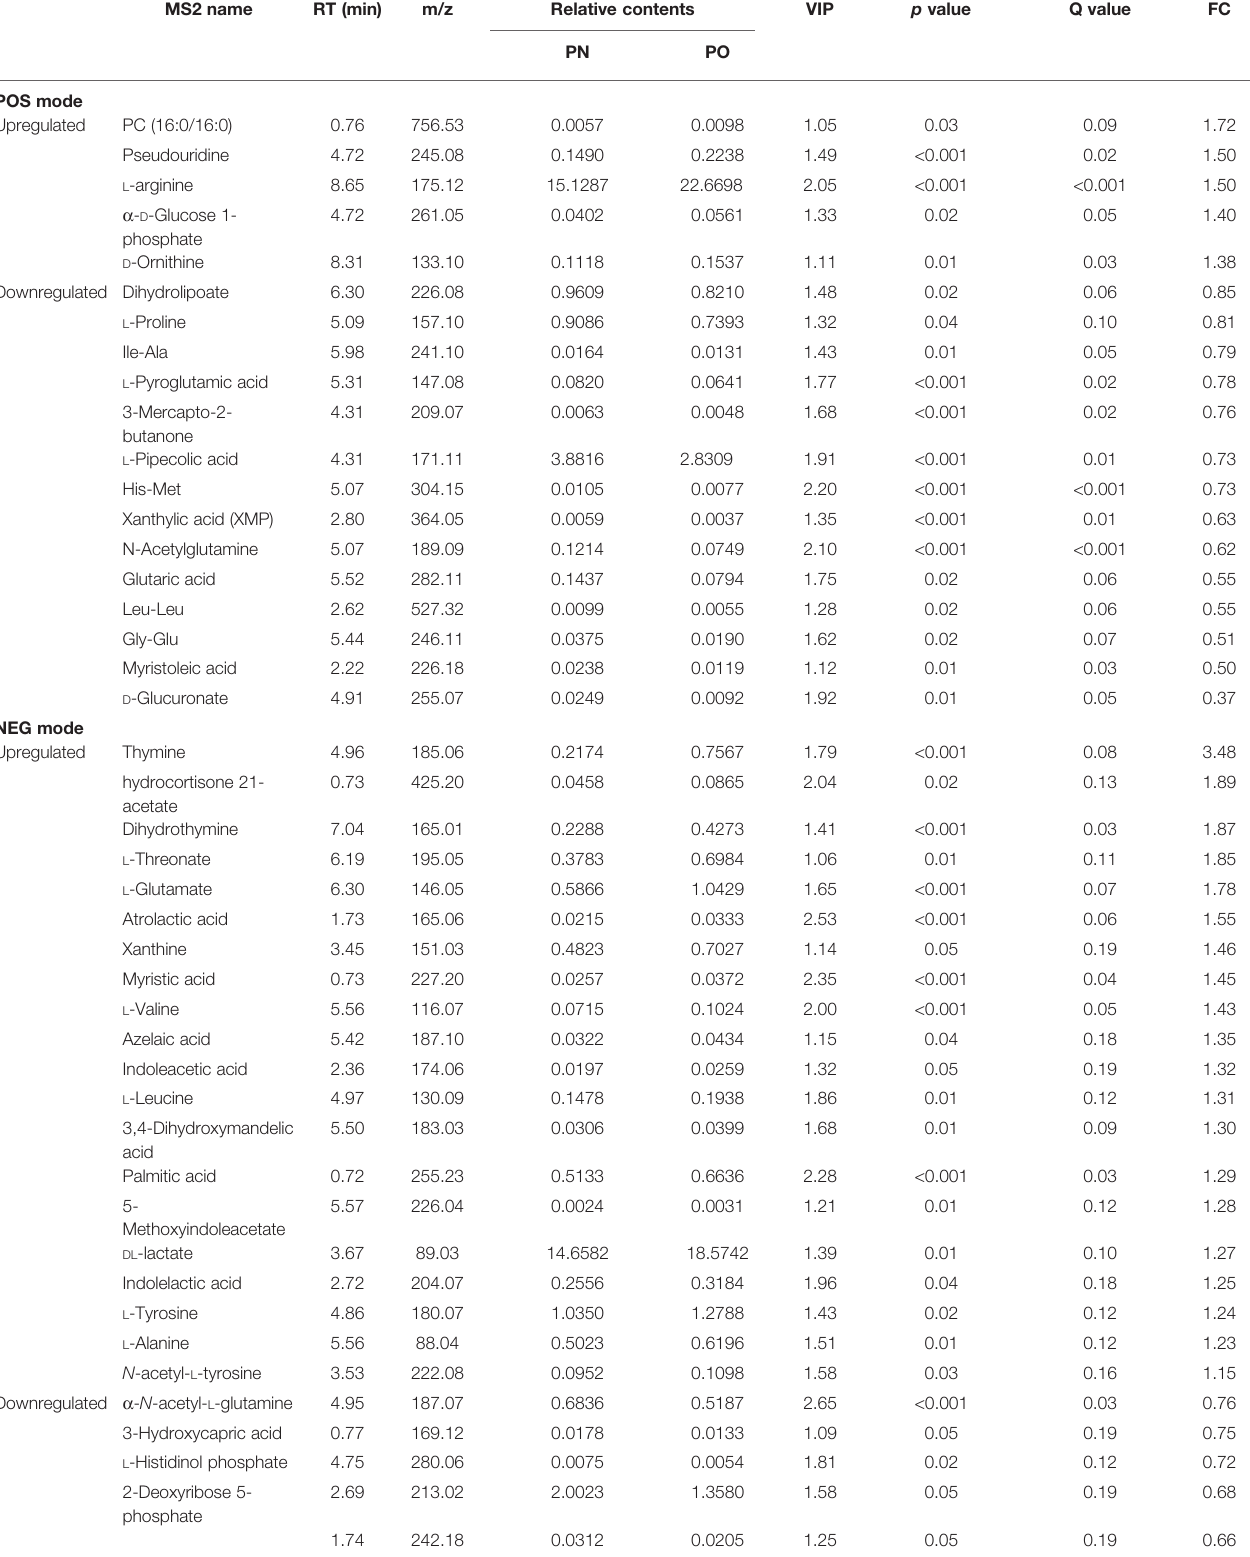
TABLE 2 | Differential metabolites identi fi ed in POS and NEG